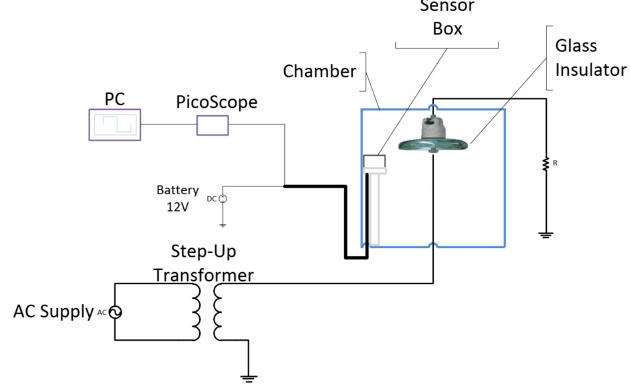
Figure 2. Schematic diagram for the overall experiment setup.